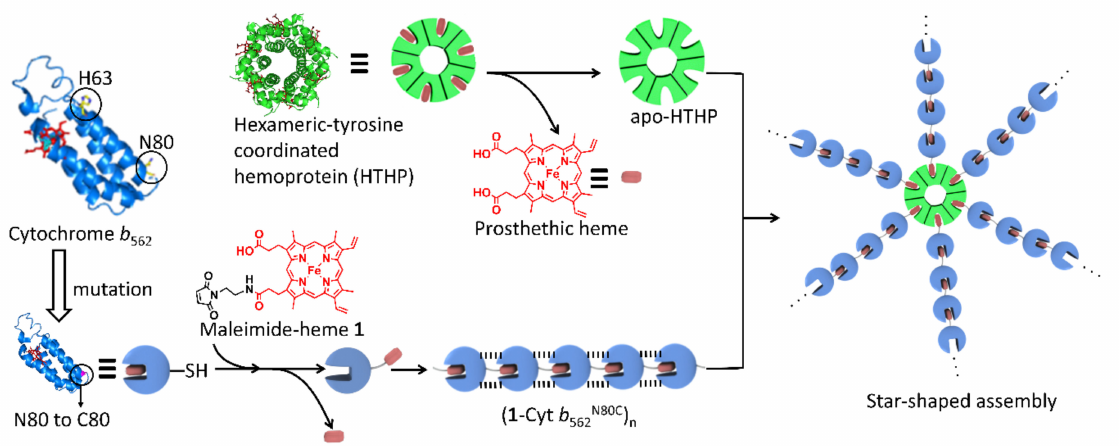
Figure 1. Schematic representation of star-shaped assembly system obtained by the incorporation of the heme moieties from the rigid linear assembly of ( 1 -Cyt b 562N80C ) n into apoHTHP (apo-form of hexameric tyrosine-coordinated hemoprotein).